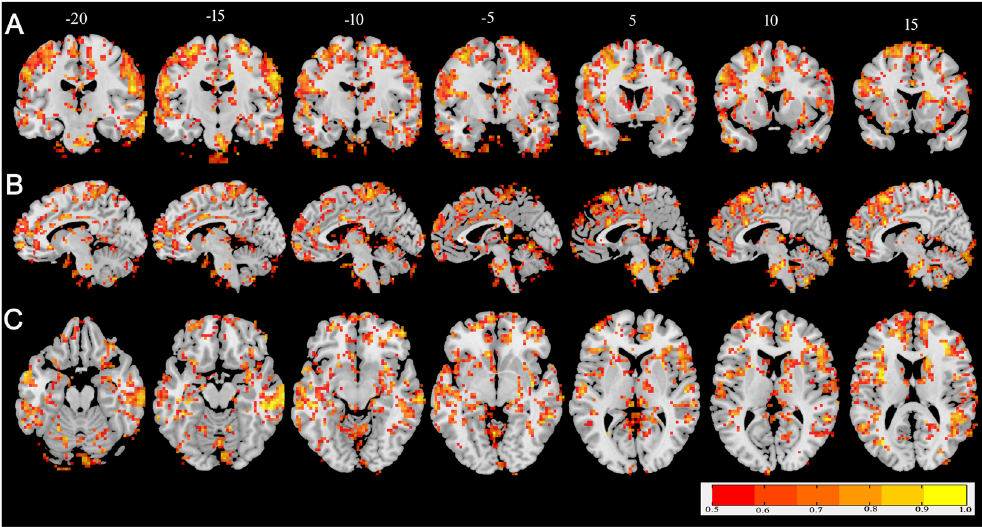
Figure 1. The intraclass correlation coefficients image thresholded at 0.5 or greater overlaid on the montreal neurological institute template brain in coronal ( A ), sagittal ( B ) and axial views ( C ). The color bar covers from red (ICC = 0.5) to yellow (ICC =